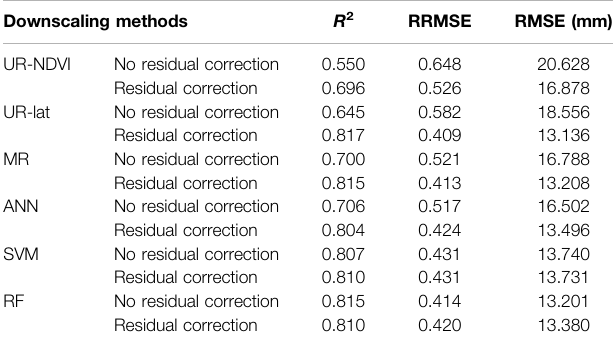
TABLE 5 | Comparison of the mean evaluation metrics of the different downscaling methods from 2001 to 2015 with and without residual correction.